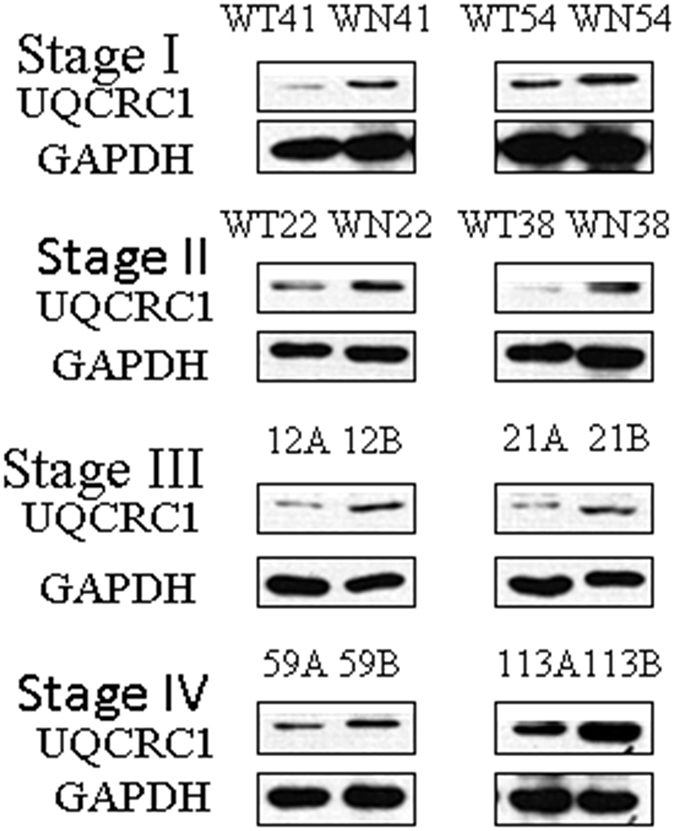
Validation of UQCRC1 expression by Western Blot.Representative Western Blot images of UQCRC1 expression in stages I–IV GC samples (A or WT. cancer, B or WN. normal gastric tissue). The blots were cropped and full length blots are presented in Supplementary Figure S4.